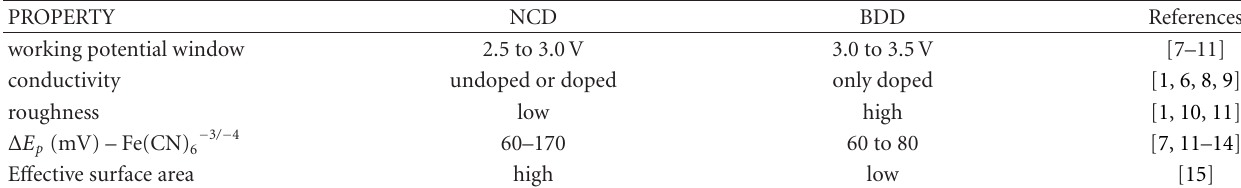
Table 1: A comparison of the some properties of the NCD and